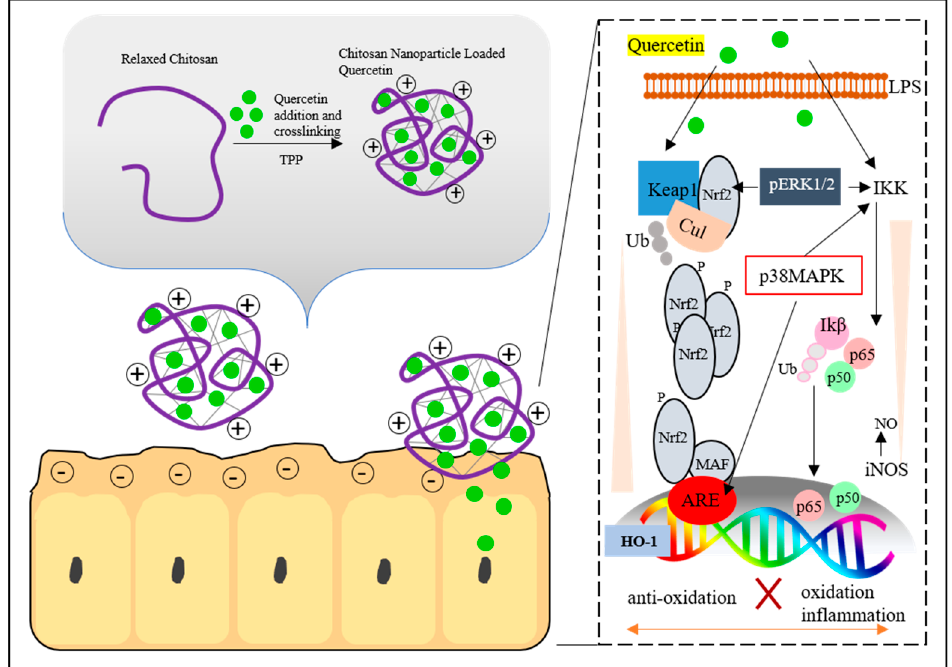
Figure 3. Scheme of the quercetin (Q)-loaded chitosan (CS) nanoparticle mechanism of action. The relaxed polysaccharide structure of the chitosan is crosslinked with tripolyphosphate (TPP). The Q is entrapped in the CS structure. The positive charge of NPs electrostatically interacts with the negatively charged epithelial cell wall. Quercetin triggers a hepato-protective cascade that leads to antioxidant protection via stimulation of nuclear factor E2-related factor 2 (Nrf2)-induced heme-oxygenase-1 (HO-1) production. Transcriptional response is mediated by the acting element termed (ARE) found in the promoters of genes encoding the detoxication enzymes. Q-inhibited lipopolysacharide (LPS) induced nitric oxide synthase (iNOS) and NO production via I κ B kinase (IKK) and p38 mitogen-activated protein kinases (p38MAPK). The proposed mechanism of action of quercetin is adapted from [166], with permission from Public Library of Science, 2015.